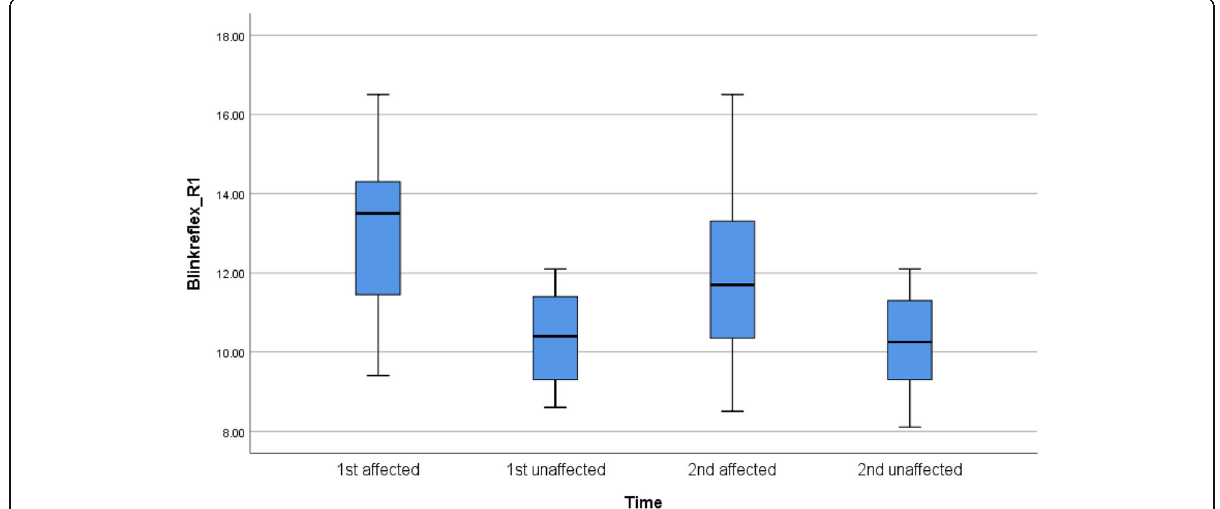
Fig. 4 R1 among the studied patients at 1st and 2nd